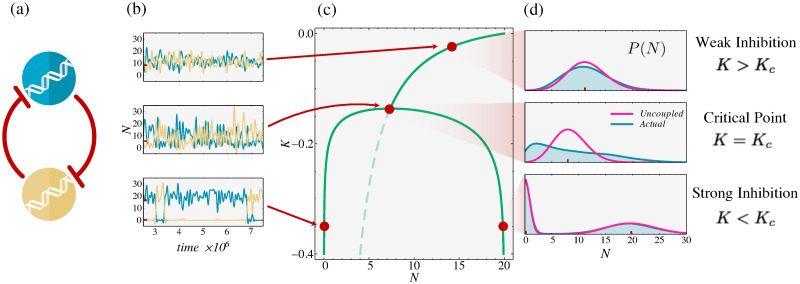
The toggle switch 2-gene network.(a) A and B inhibit each other. (b) Time trajectories of protein number NA (blue) and NB (yellow), simulated from the Ground Truth (Eq 24). (c) Its phase diagram, from the Uncoupled Max Cal Approximation. (green). Solid green: stable phases. Dashed green: unstable phase. Red dots (top to bottom and corresponding to Ground Truth simulations): Supercritical, single state (K > Kc). Critical point (Kc), big fluctuations. Subcritical, toggle switch, two bistable states (K < Kc). (d) The histograms of populations P(N) in each case, comparing the Ground Truth (blue) to the Uncoupled result (magenta). The red lines correspond to the markers in the phase diagram. Uncoupled Max Cal captures the distribution correctly except at the critical point (center, truncated power law).